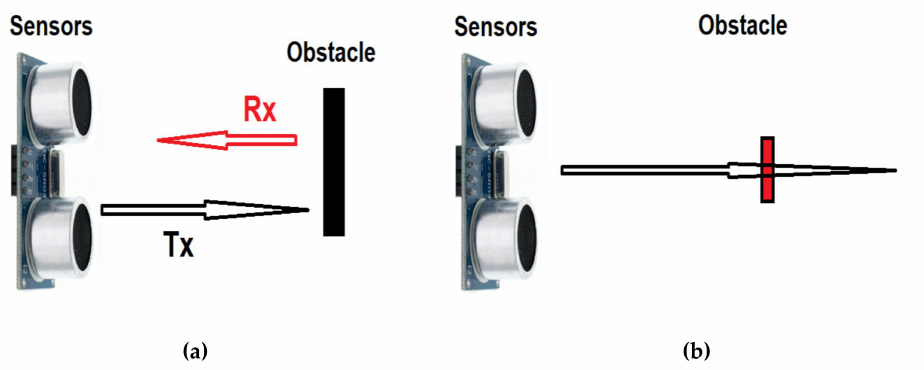
Figure 16. Ultrasonic sensors for detection of small obstacles. Reflection received from targets larger than the wavelength ( a ), and error of detection for smaller objects than the wavelength ( b